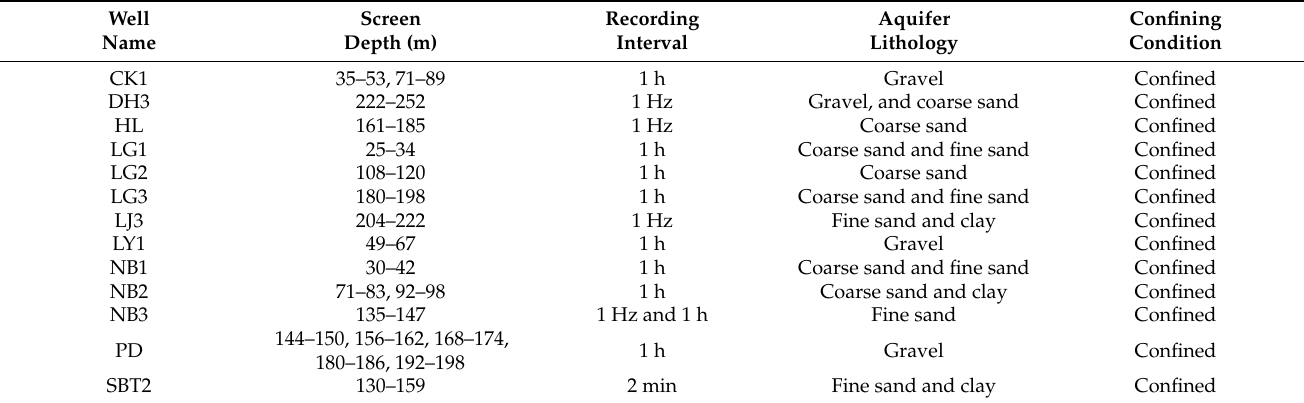
Figure 2. The associated hydrogeological units and screen intervals of the monitoring stations/wells used in the study. Each station might have multiple wells perforated at different depths (the lithology at Station CK was unreliable and not shown in the figure). Table 1. Information on the monitoring wells used in this study.